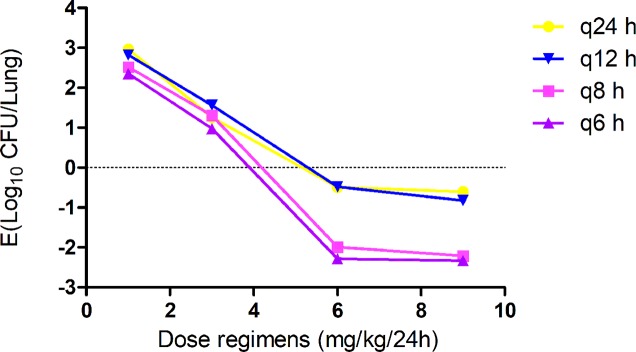

In vivo dose fractionation with gamithromycin using the murine neutropenic lung infection model. Each symbol represents the mean value of lung bacterial infection from three mice infected with Pasteurella multocida NM-5-7. Sixteen dose regimens of gamithromycin were used to treat the P. multocida NM-5-7 infection. The change in the log10 number of colony-forming unit (CFU)/lung was measured at the start and after 24 h of therapy. Data points below the horizontal dashed line represent killing, and points above the horizontal dashed line represent growth.